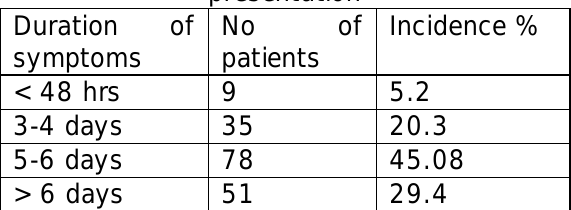
Table 2. Duration of symptoms